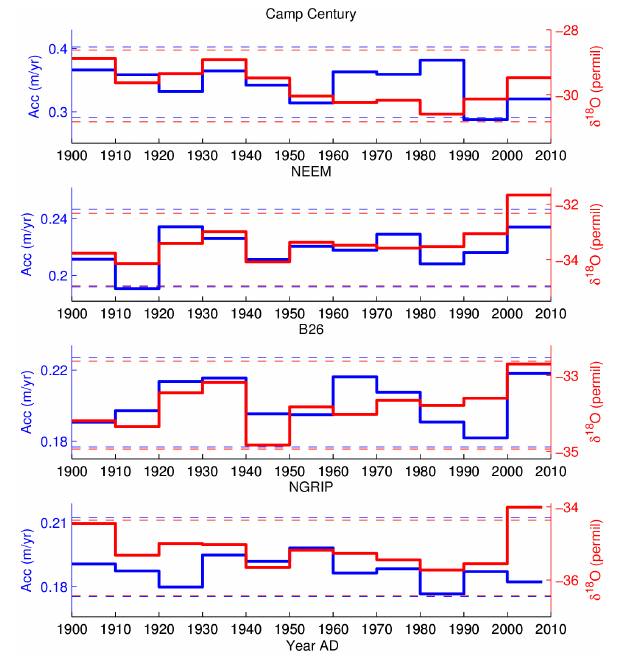
Fig. 4. Average values of accumulation rates (blue) and δ 18 O val- ues (red) for each decade since 1900AD. The blue and red dashed lines indicate the mean value ± 2 σ of accumulation rate and δ 18 O, respectively, for the whole data period for each record. The peri- ods of data for the four records are Camp Century: 1762–2009AD, NEEM: 1737–2009AD, B26: 1900–2009AD, and NGRIP: 187– 2007AD.